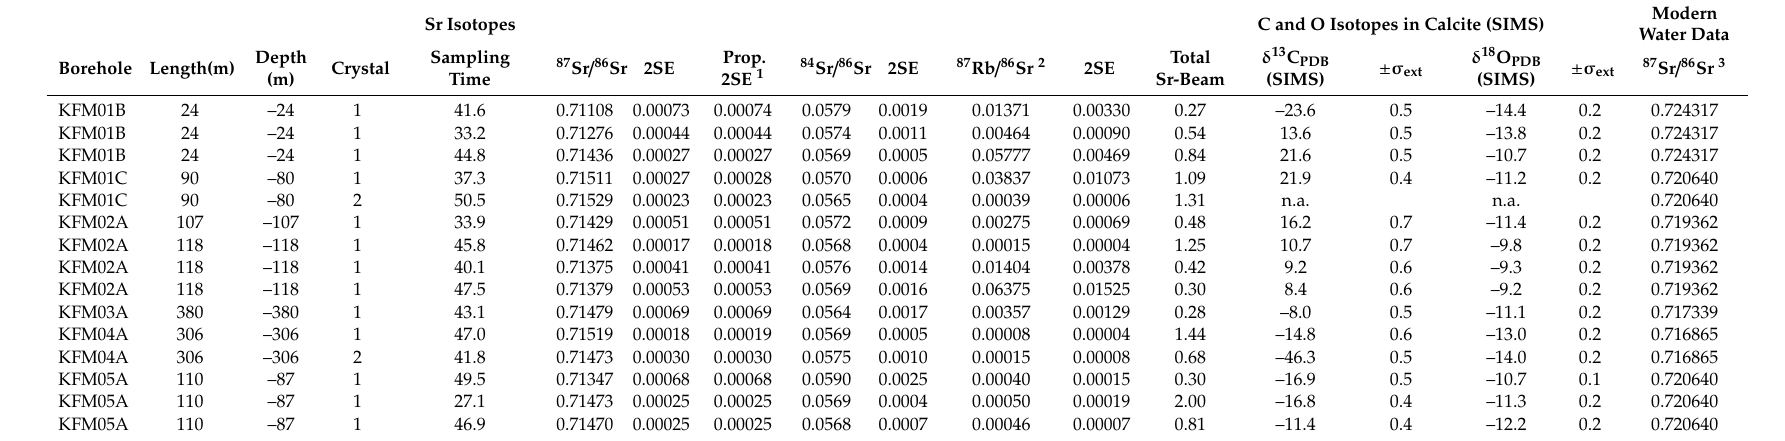
Table 2. Forsmark (n = 31), 11 boreholes, 12 samples. 18 calcite